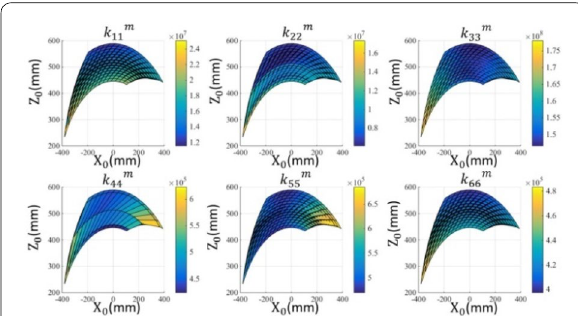
Figure 7 Distribution of stiffness over the workspace of the parallel